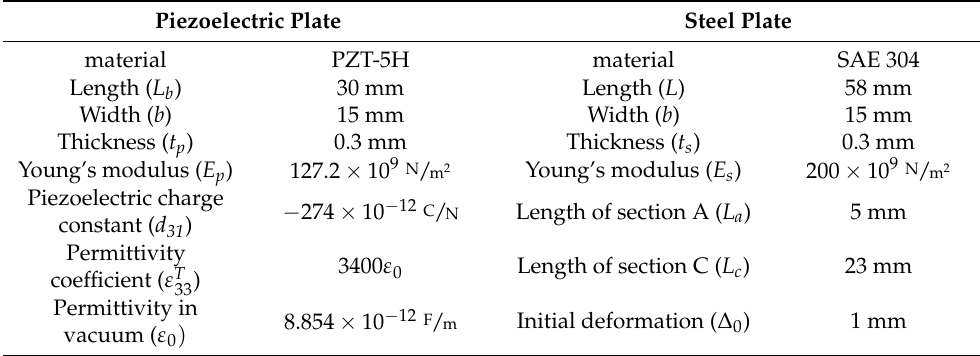
Figure 9. Measured results of vibration amplitude on front end of cantilever beam and motion trajectory of plucking mechanism. Table 2. Dimension and parameters of proposed piezoelectric unimorph plate to be utilized in electric power calculation by theoretical equivalent circuit.